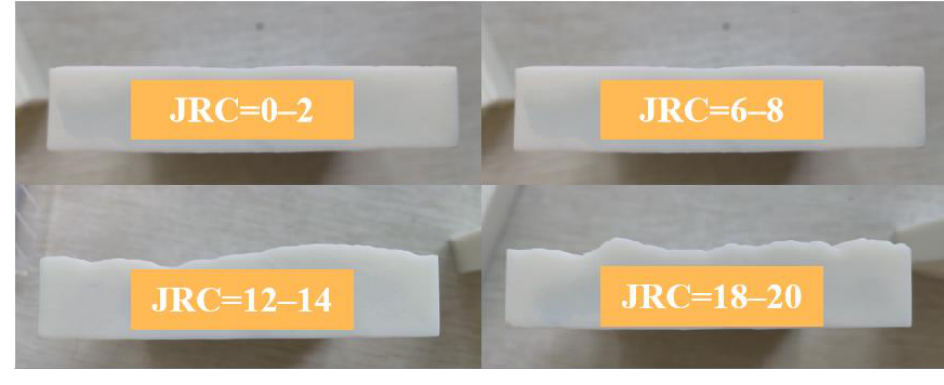
Figure 2. Different JRC molds.